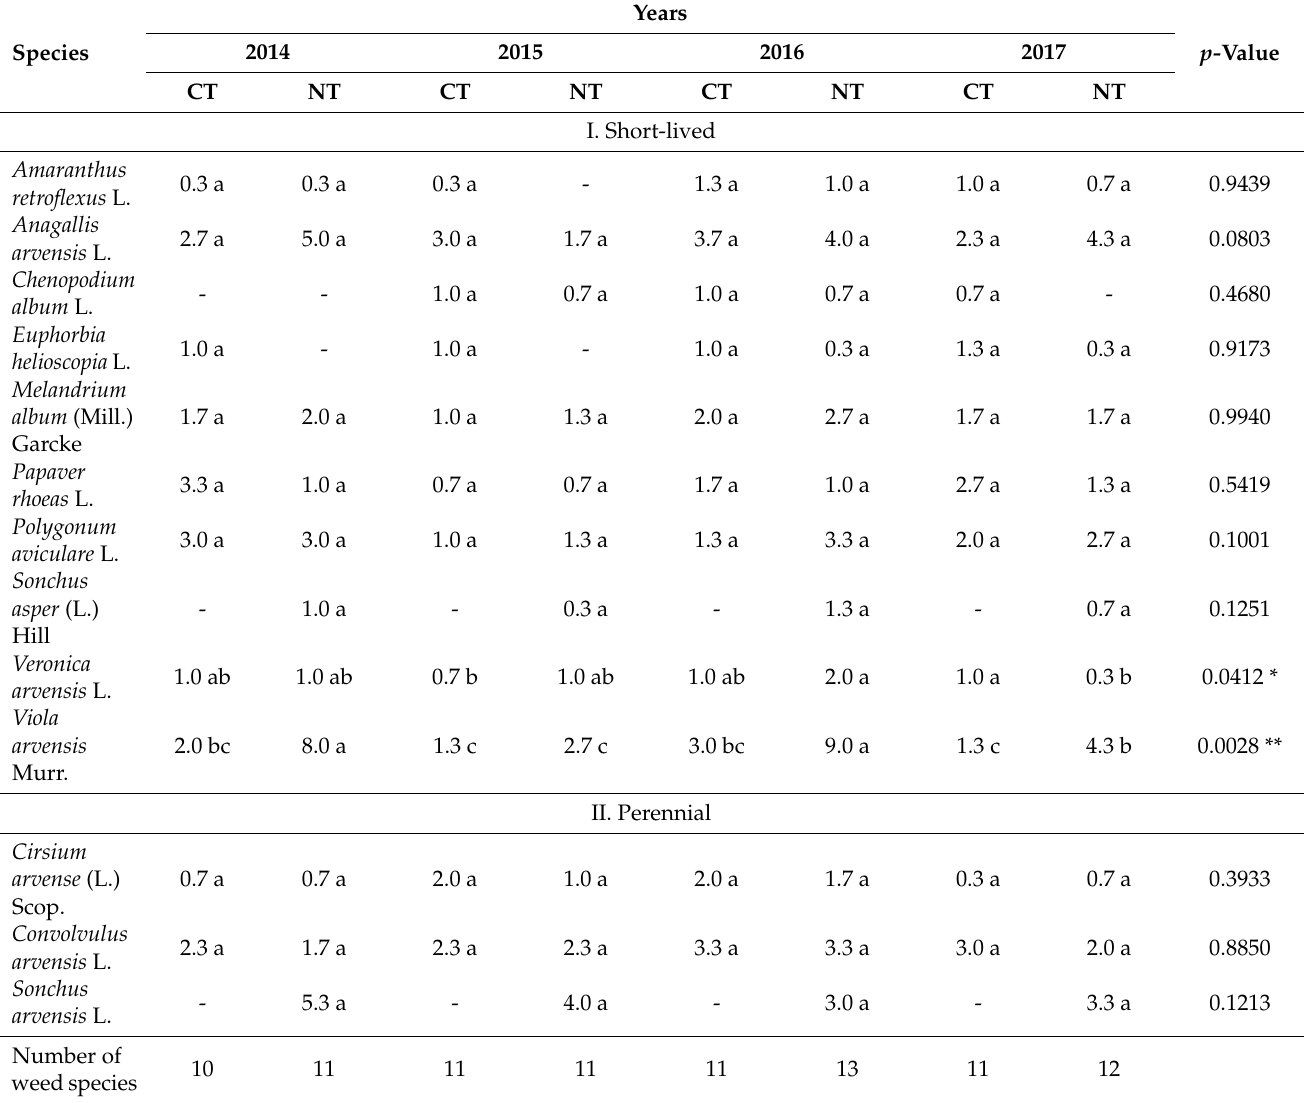
Table 10. Interactive dependencies of tillage systems and years of research in determining weeds composition per 1m 2 in winter oilseed rape